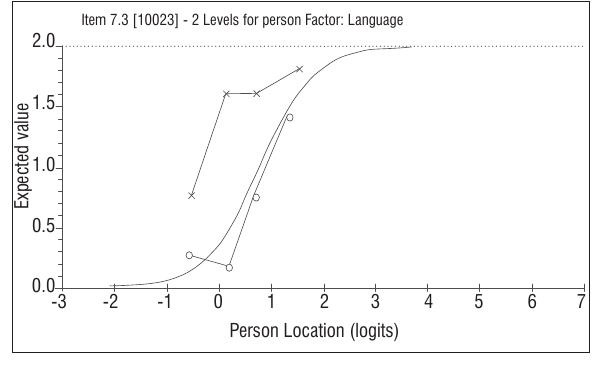
Item characteristic curve for Question 7.3, showing significant differential item functioning for language. English first language is represented by the crosses and English second language by the